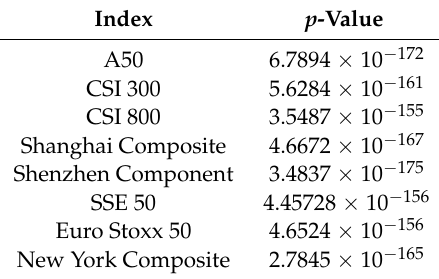
Table 6. Wilcoxon test comparing the error rate using neural networks directly with all the 35 technical indicators and the algorithm output.